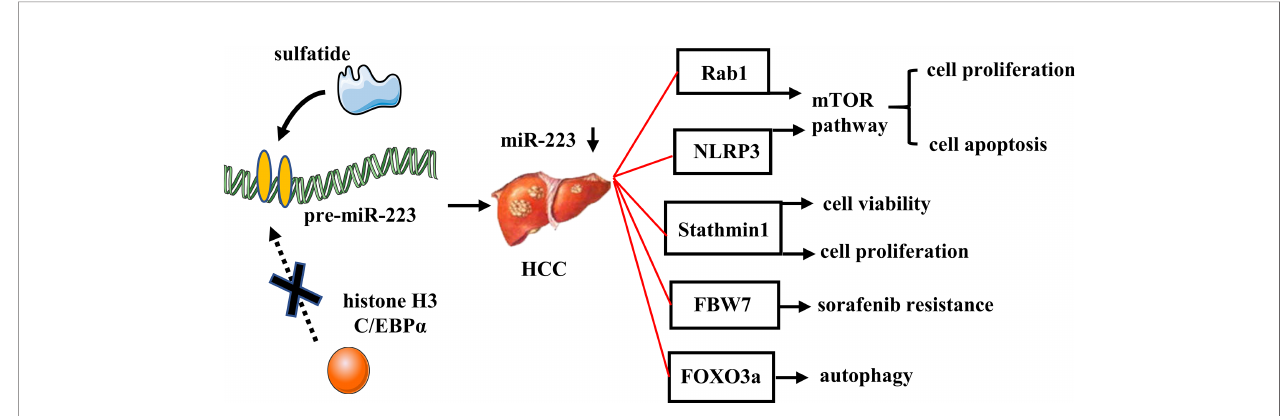
FIGURE 5 | Role of miR-223 in HCC. In HCC, sulfatide acts on the promoter region of pre-miR-223, thereby reducing the recruitment of histone H3 with C/EBP a and decreasing miR-223 expression. MiR-223 directly targets Rab1, NLRP3, Stathmin1, FBW7, and FOXO3a, which involved in tumor cell proliferation, apoptosis, autophagy, and drug